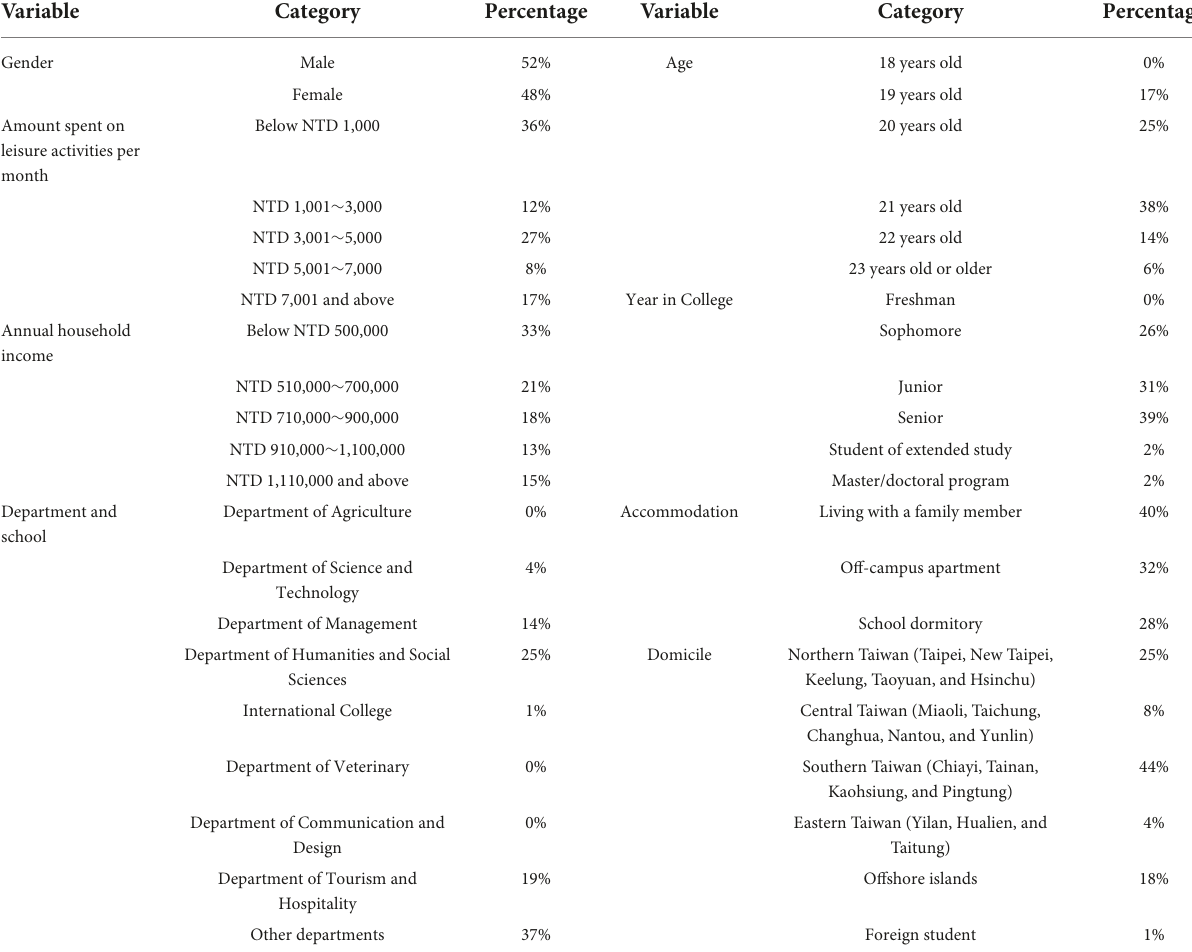
TABLE 1 Basic information background